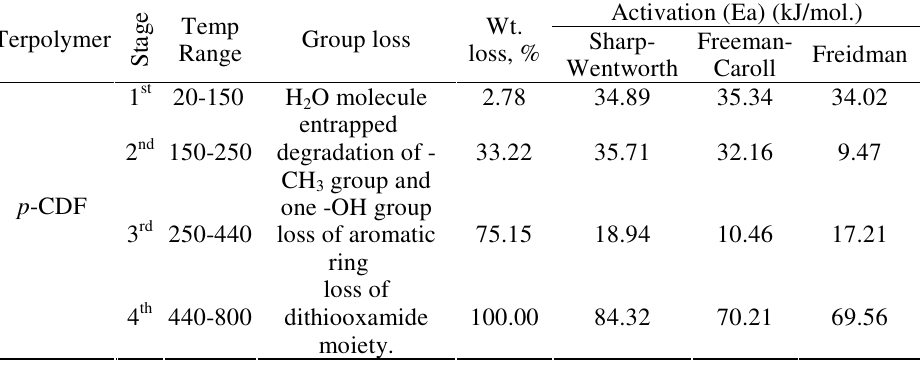
Figure 4. Thermogram of p -CDF terpolymer resin Table 3. Comparison of activation energy (Ea) of degradation at different stages by different methods of p -CDF